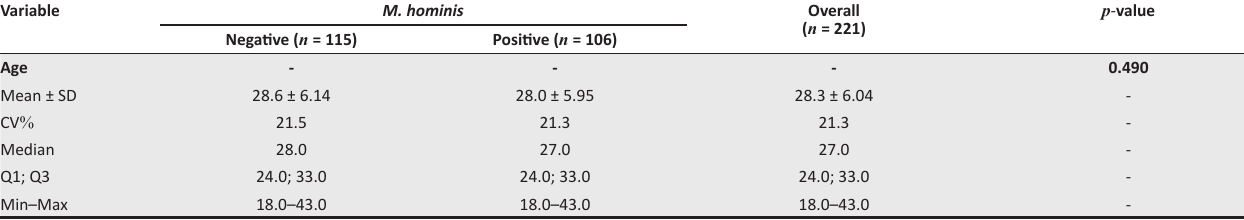
TABLE 1a: Characteristics of the study population by Mycoplasma hominis status. Variable